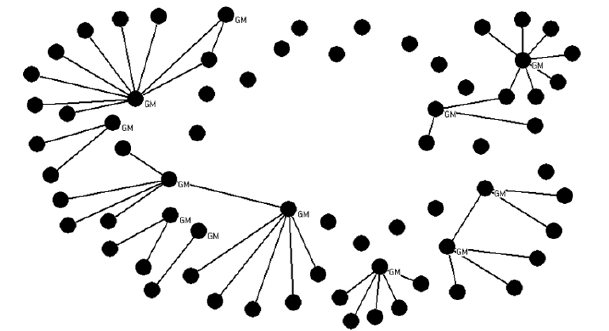
Fig. 11 . Fragmentation of Landcare Group A based on ‘what-if’ scenario.